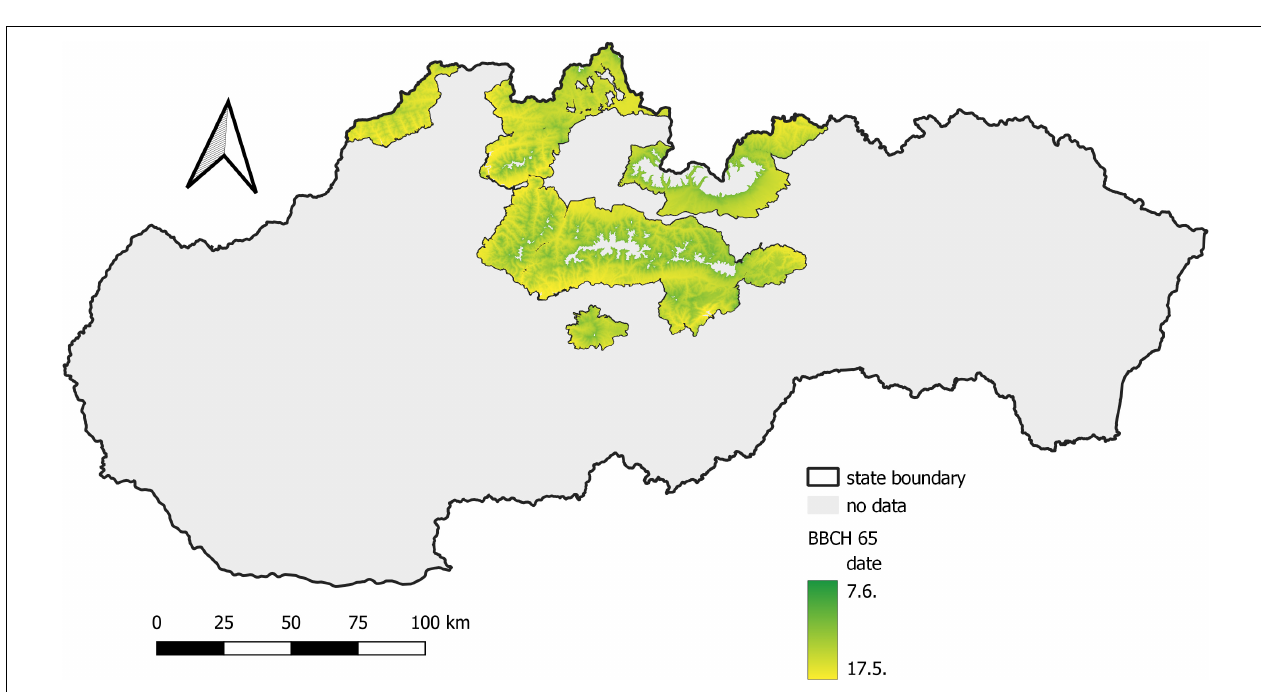
FIGURE 4 | Average onset of full flowering of Norway spruce in a period of years 1991–2020.